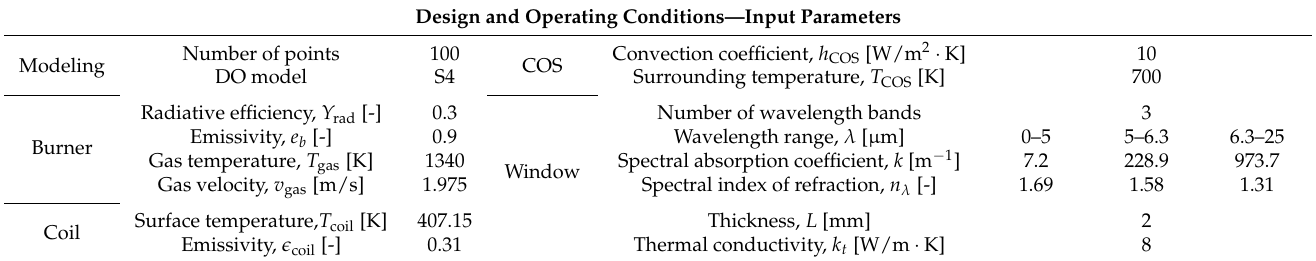
Table 2. Input parameters for reference